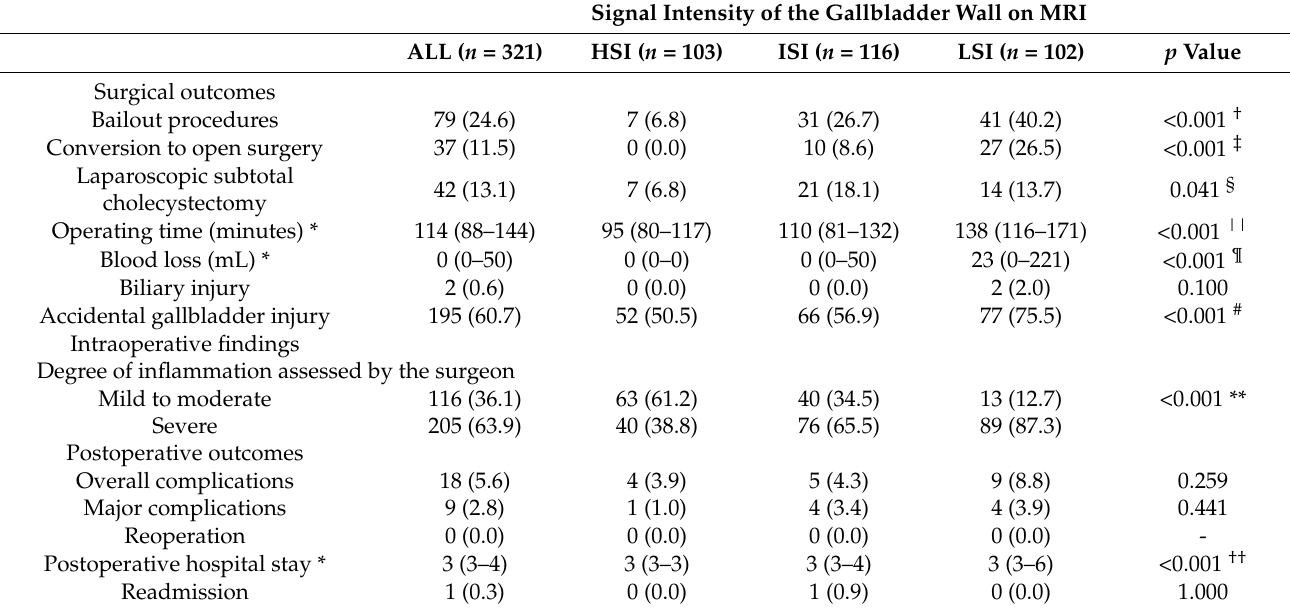
Table 2. Surgical outcomes of the three